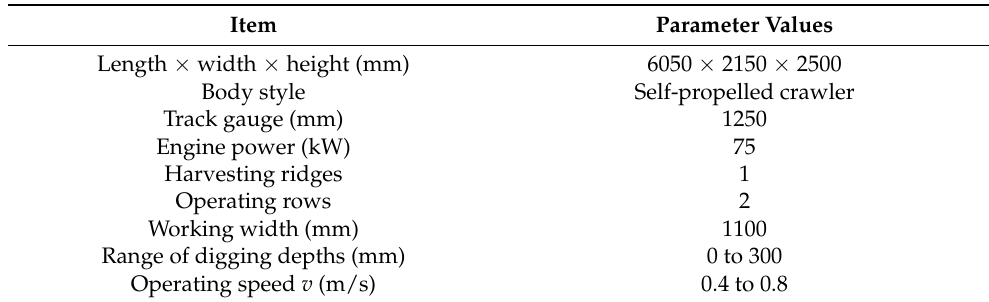
Table 1. Technical parameters of the self-propelled machine for combined potato harvesting and residual plastic film retrieval.